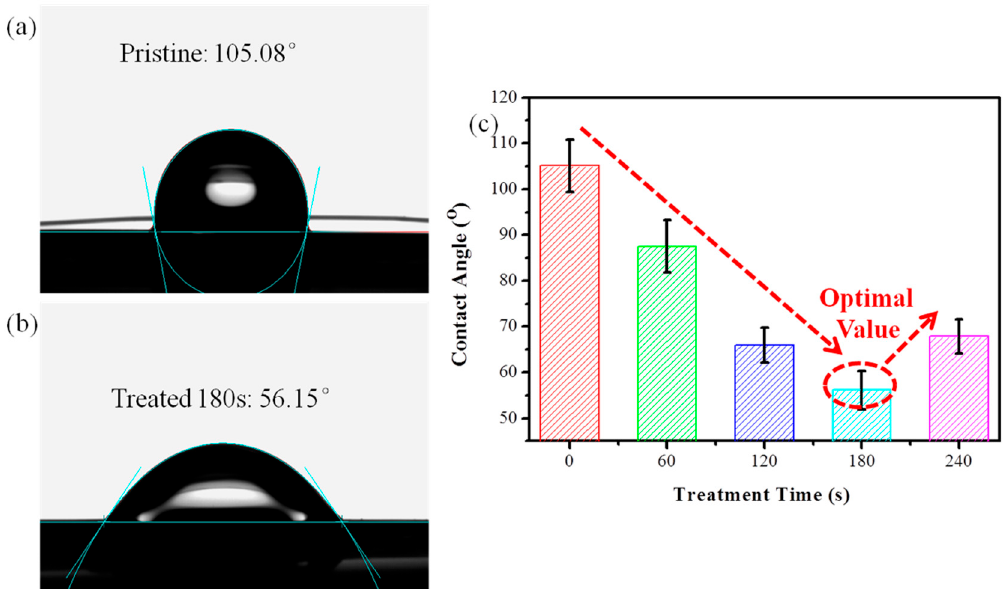
Figure 5. Photographs of water droplets on PI filaments: ( a ) pristine, ( b ) O 2 plasma treated time of 180 s and ( c ) contact angles for pristine and plasma treated PI filaments at different times.